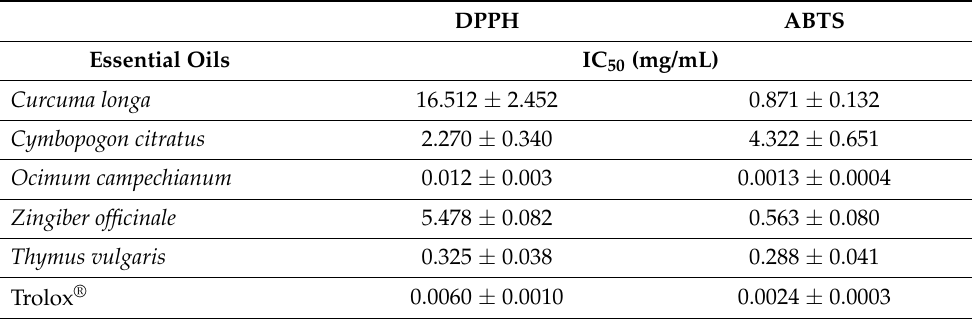
Table 4. Antioxidant properties of EOs from studied species through DPPH and ABTS tests in comparison with that of commercial Thymus vulgaris (phytocomplex as positive control), and Trolox ® (pure chemical compound as positive control). DPPH ABTS Essential Oils IC 50 (mg/mL) Curcuma longa 16.512 ± 2.452 0.871 ± 0.132 Cymbopogon citratus 2.270 ± 0.340 4.322 ± 0.651 Ocimum campechianum 0.012 ± 0.003 0.0013 ± 0.0004 Zingiber officinale 5.478 ± 0.082 0.563 ± 0.080 Thymus vulgaris 0.325 ± 0.038 0.288 ± 0.041 Trolox ® 0.0060 ± 0.0010 0.0024 ± 0.0003